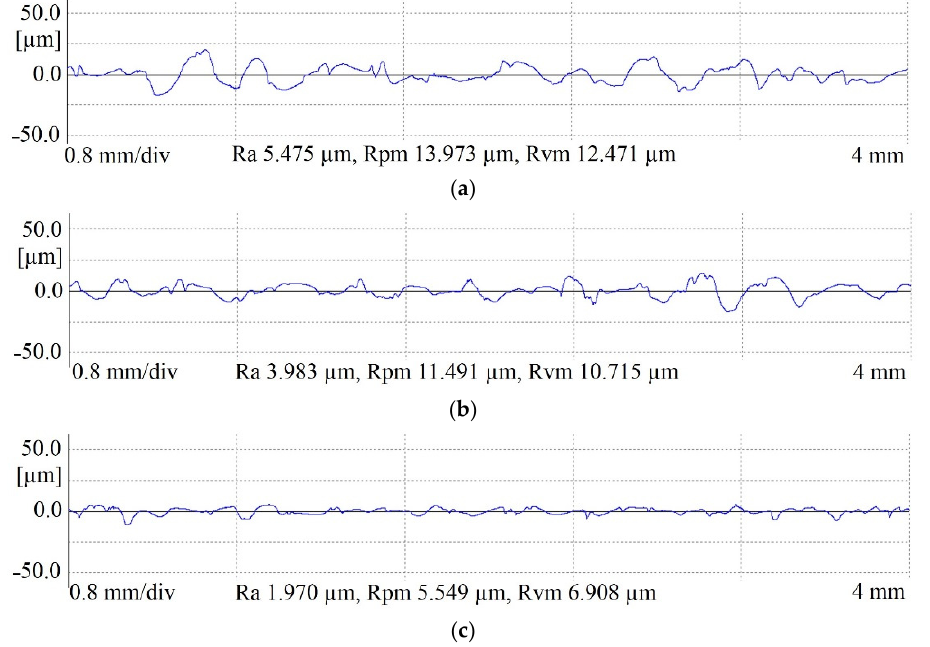
Figure 10. Profiles of the machined surface on the side wall of the hole drilled with the conventional electrode (CE). ( a ) CE Ø 12 mm; ( b ) CE Ø 9 mm; ( c ) CE Ø 6 mm.